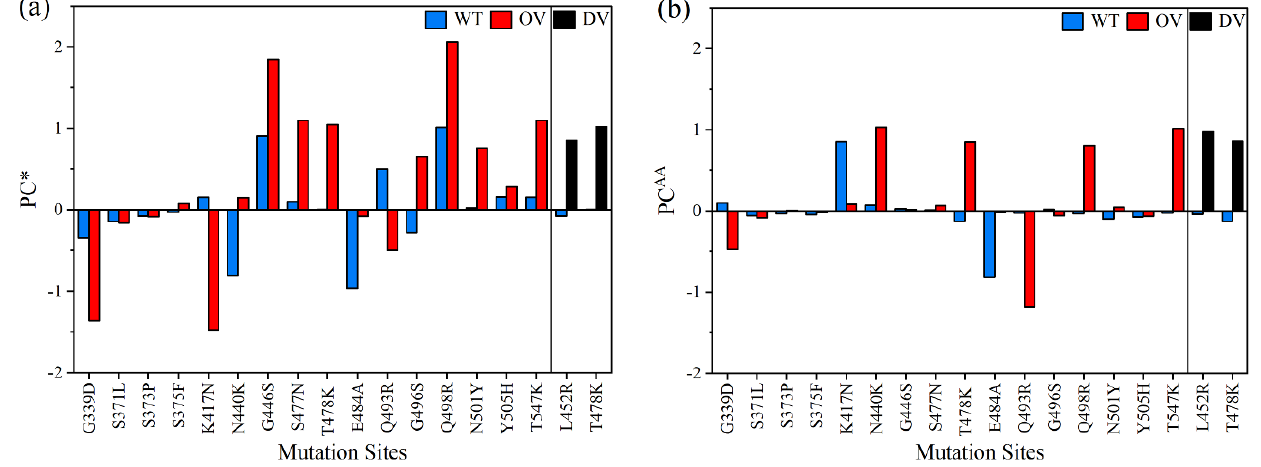
Figure 5. ( a ) Partial charge per AABPU (PC*) and ( b ) partial charge distribution of each AAs (PC AA ) in unit of electron (e) at 18 mutation sites of RBD ‐